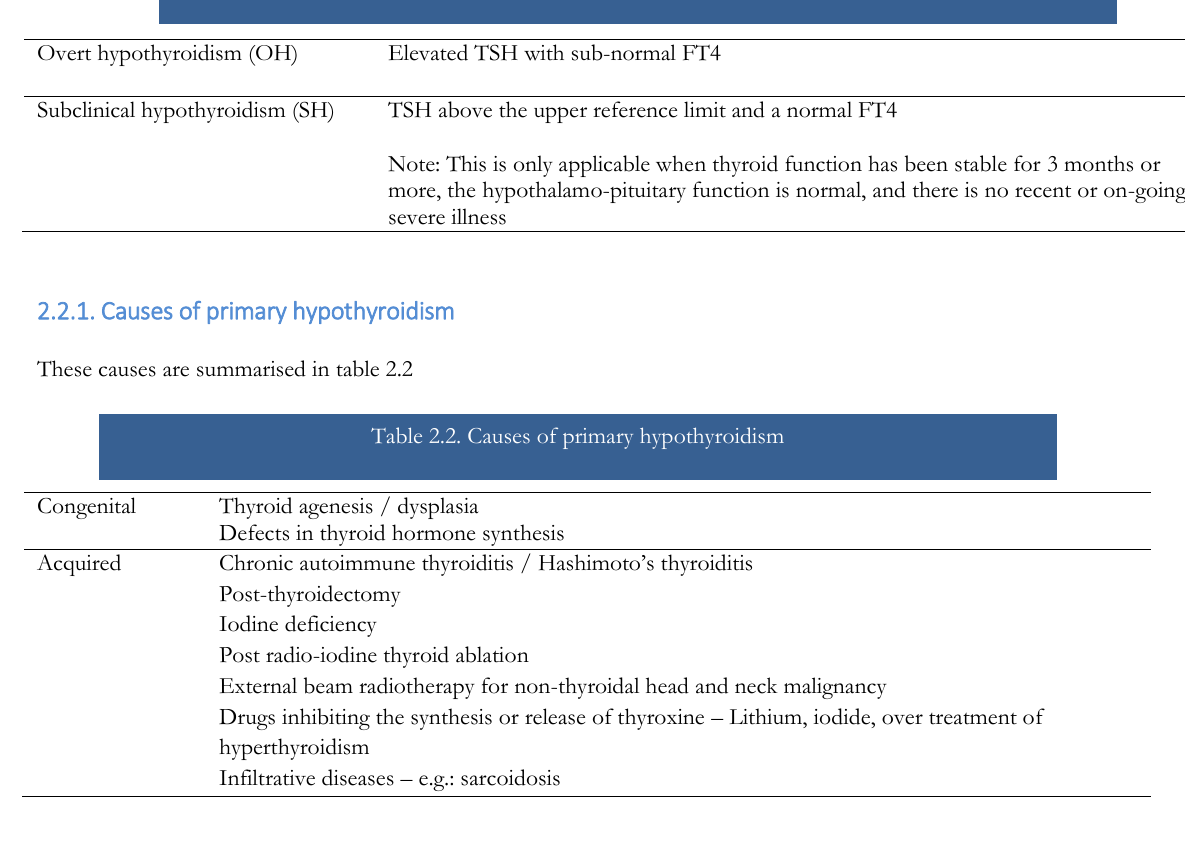
Table 2.1. Classification of primary